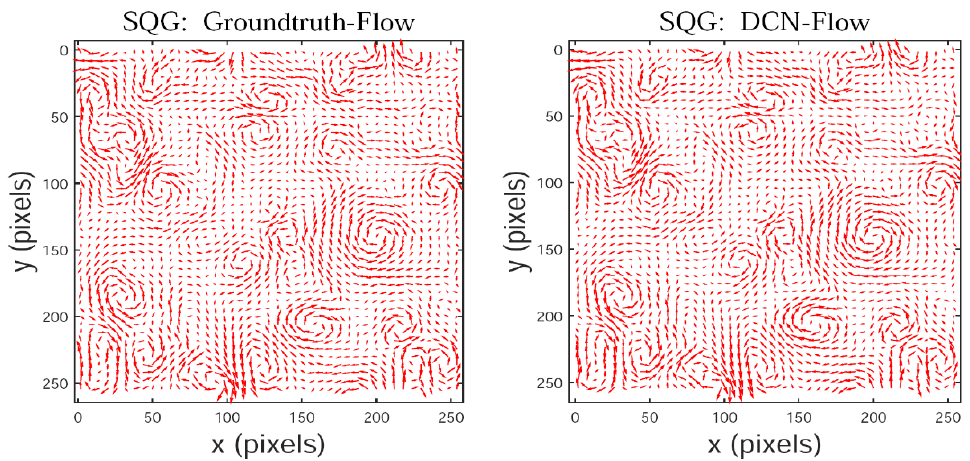
Figure 13. The flow vectors of SQG estimated by our method (DCN-Flow).